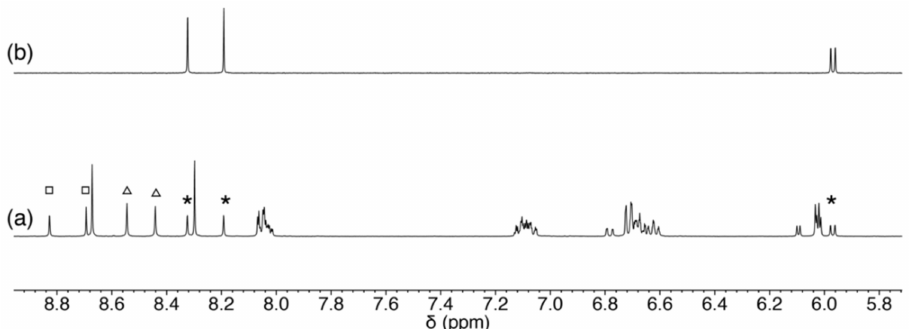
Figure 10. 1 H NMR spectra of ( a ) the reaction mixture of 1 and adenosine, and ( b ) adenosine in CD 3 OD. The resonances of aryl-H atoms for two minor products and adenosine are marked in the spectrum ( Pd-A2 : open triangle; Pd-A3 : open square; adenosine: